Question: Give a one-sentence summary of this figure.
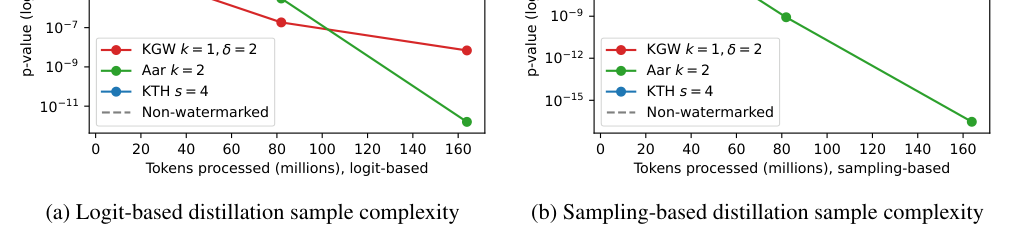
Answer: Watermark detection p-values of generations from logit-based (a) and sampling-based (b) distilled Llama 2 7B models trained on varying numbers of tokens. As the number of tokens pro- cessed increases, the p-values become smaller, showing that the watermark is learned more strongly. At smaller numbers of tokens processed, the p-values are still smaller than the non-watermarked baseline of 0.5, indicating that the watermark is still learned, albeit less strongly.